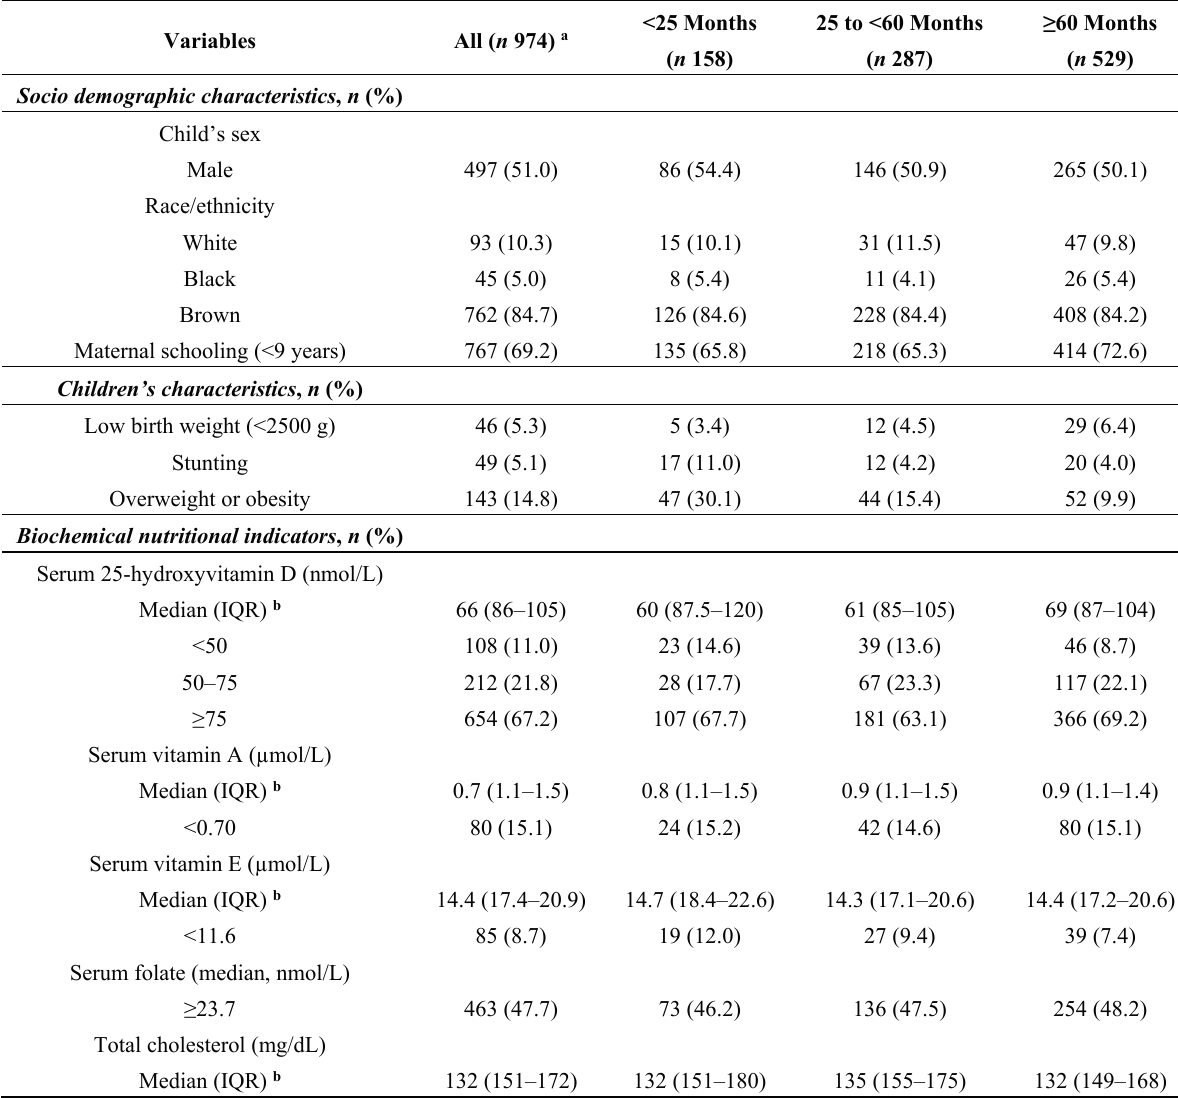
Table 1. Characteristics of children included in the study according to age group (Acrelândia, Brazil,